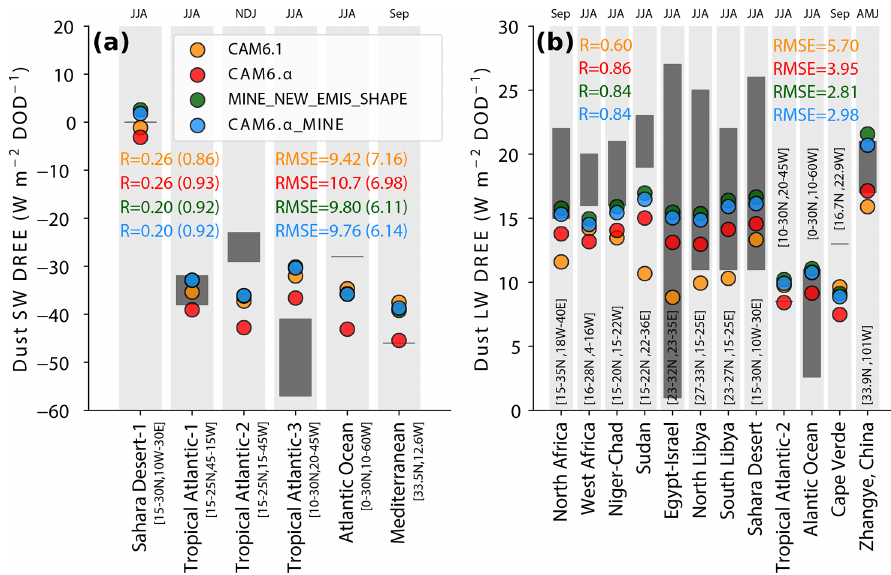
Figure 9. Modeled and observed dust direct radiative effect efficiency (DREE) in the shortwave (SW; a ) and longwave (LW; b ) spectral ranges under clear-sky conditions at the TOA over the sub-domains (see labels of the x axes) in April–June (AMJ), summer (JJA), fall (NDJ), and September (Sep) for the 2000s climate. The DREE is defined as the ratio of DRE to DOD, so has units of Wm − 2 DOD − 1 . Included cases from left are CAM6.1, CAM6. α , MINE_NEW_EMIS_SHAPE, and CAM6. α _MINE. Colored numbers show correlation coefficient ( R ) and the root mean square error (RMSE) between the model and retrievals in the SW and LW spectral ranges or in both spectral ranges (numbers in parenthesis in panel a ).